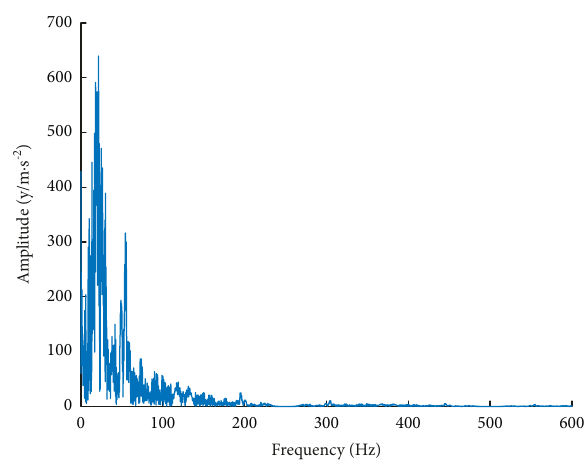
Figure 12: Spectrum of vertical acceleration at hinge